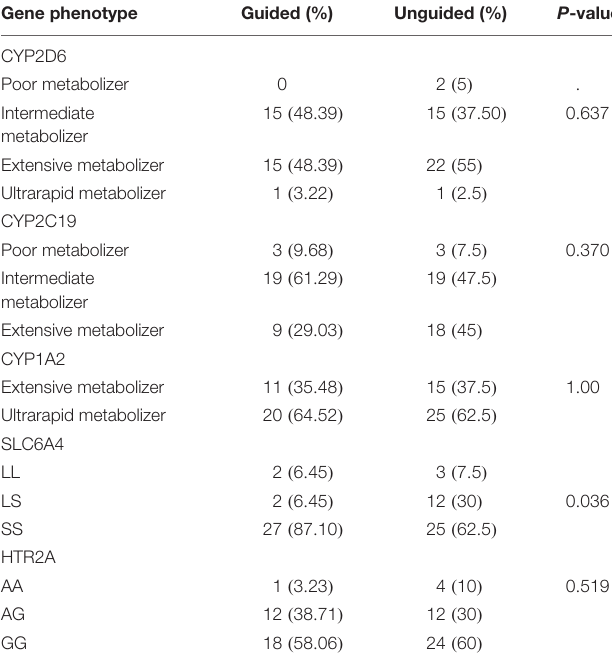
TABLE 1 | Demographic characteristics of the study.